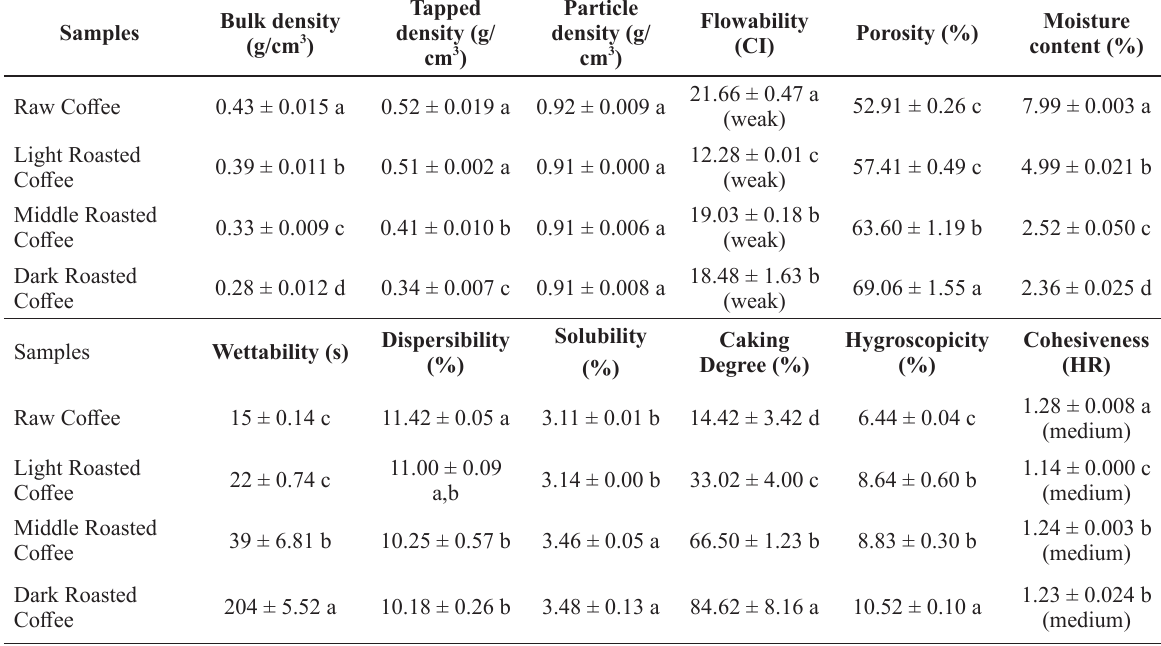
Physical properties of Arabica ground coffee samples at different roast